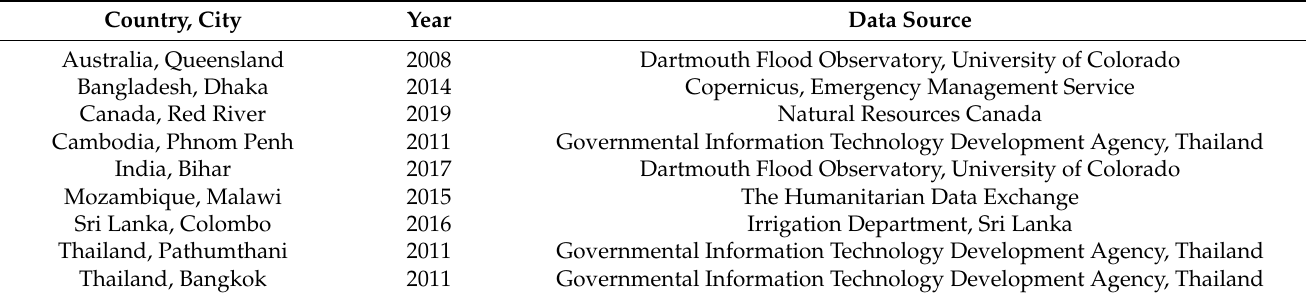
Table 2. Location, event, and data source for each flood event used for